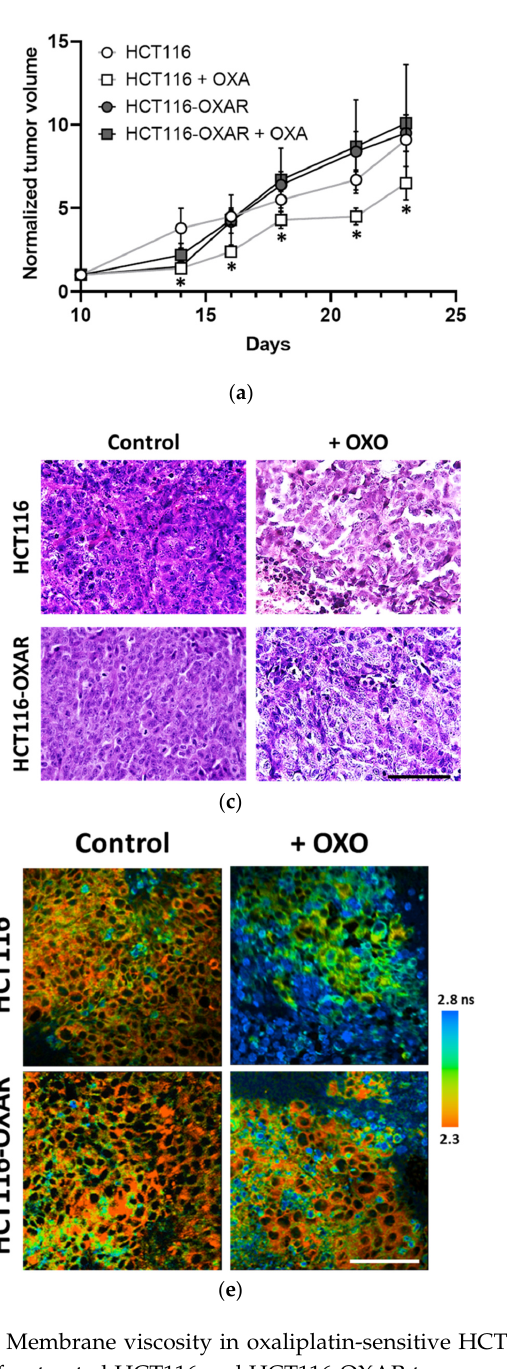
10 of 18 OXAR cell lines: longer incubation led to a decrease in the percentage of unsaturated fatty acids. Principal component analysis (PCA) is routinely used for revealing similarities or differences in the mass spectra of different samples [17]. Figure 5 depicts the differences in the chemical composition of the membranes of control and resistant cells with and with- out oxaliplatin treatment both in their positive and negative ions. The chemical profiles of the control and resistant cells were also different. At the same time, the greatest similarity was found between treated HCT116 and untreated HCT116-OXAR cells in positive ions. Overall, these data suggest that both treatment with oxaliplatin and the acquisition of re- sistance are accompanied by complex rearrangements in the lipid bilayer of the cancer cells. ( a ) ( b ) Figure 5. Principal component analysis of ToF-SIMS results demonstrating the differences between HCT116 and HCT116- OXAR cells in membrane lipid composition. The data from untreated and oxaliplatin-treated (2.0 μ M, 1 or 24 h incubation) cells were analyzed. ( a ) Scores plots on PC1 and PC2 resulting from PCA in positive ion mode. ( b ) Scores plots on PC1 and PC2 resulting from PCA in negative ion mode. A 95% confidence limit for each region was defined by an ellipse with the same color to the corresponding region clusters . Each data point represents an individual field of view. Different